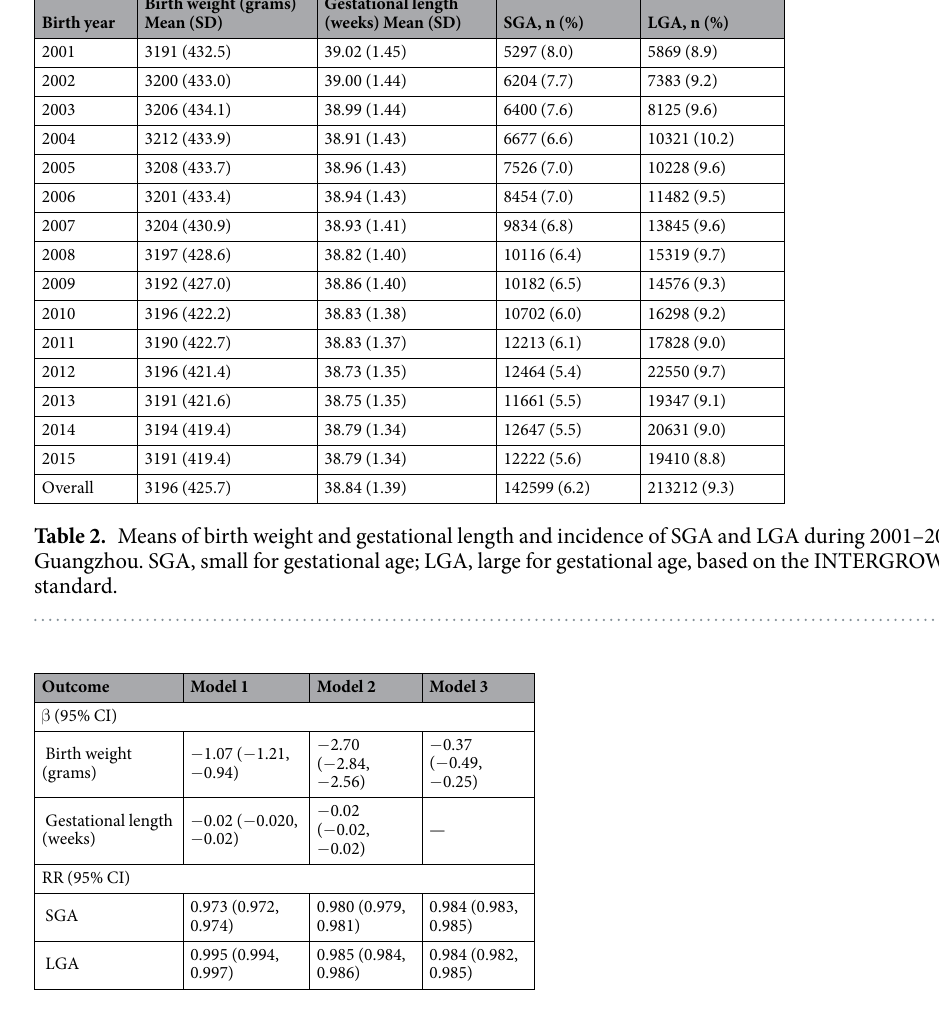
Table 3. Change per year in incidence of SGA and LGA and birth weight and gestational length. SGA, small for gestational age; LGA, large for gestational age, based on the INTERGROWTH-21st standard. Model 1, no adjustment. Model 2, adjusted for mother’s age at delivery, parity and infant sex. Model 3, adjusted for variables as in model 2 plus gestational